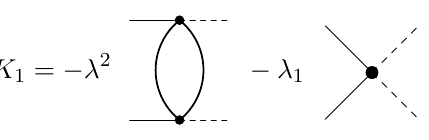
Figure 8 . Graphical representation of the kernel K 1 (4.25). Solid lines represent full two-point functions, while dashed lines represent amputated external legs. For obvious reasons we call the first term “ladder kernel” and the second “local